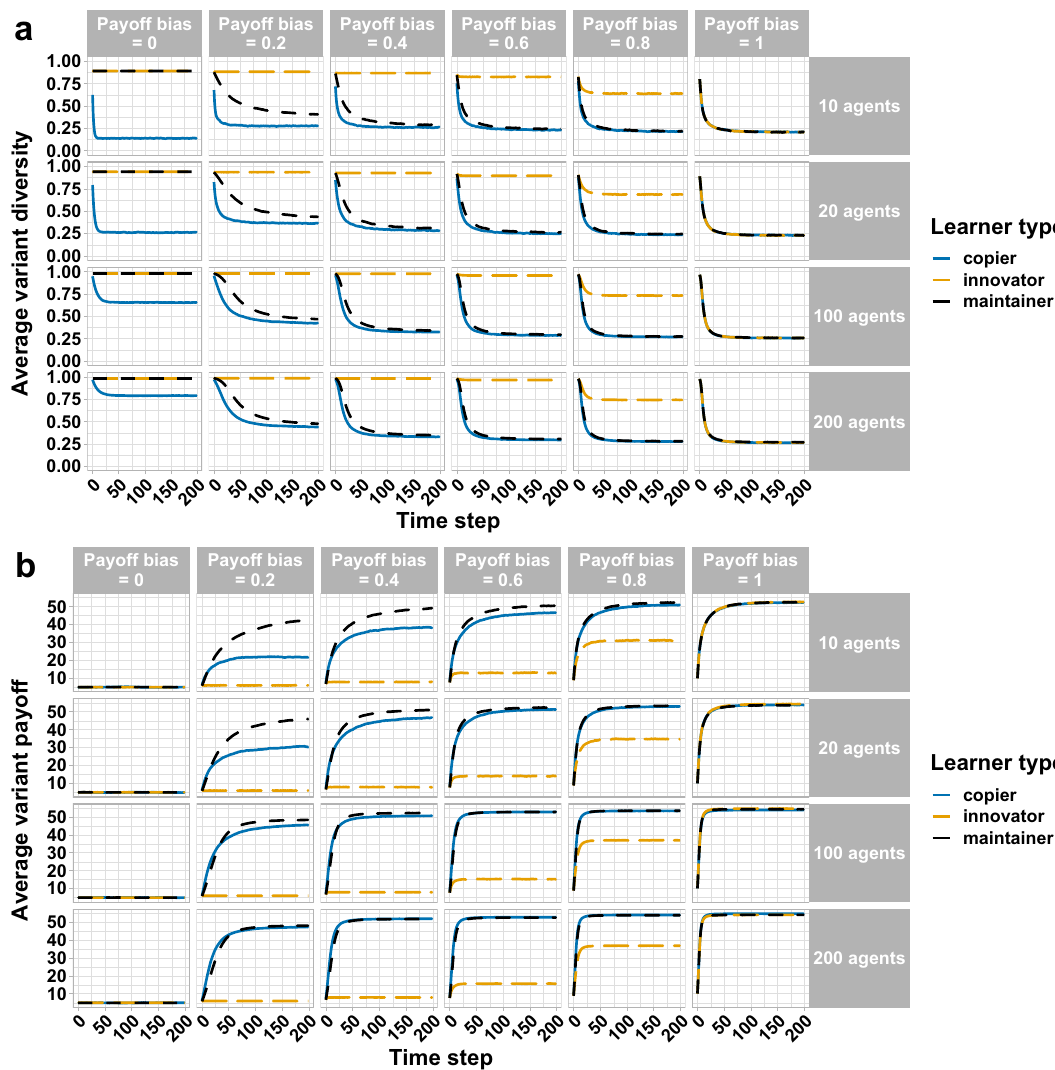
Figure 3. Change in cultural diversity ( a ) and average variant payoff (adaptation) ( b ) over 200 time steps as a function of the different parameter combinations (payoff bias, learner type and population size). Populations were unstructured. Variant diversity was measured by the Gini-Simpson index of diversity (maximum for 10-, 20-, 100- and 200-agent populations = 0.9, 0.95, 0.99 and 0.995 respectively). Each line is the average of 10,000